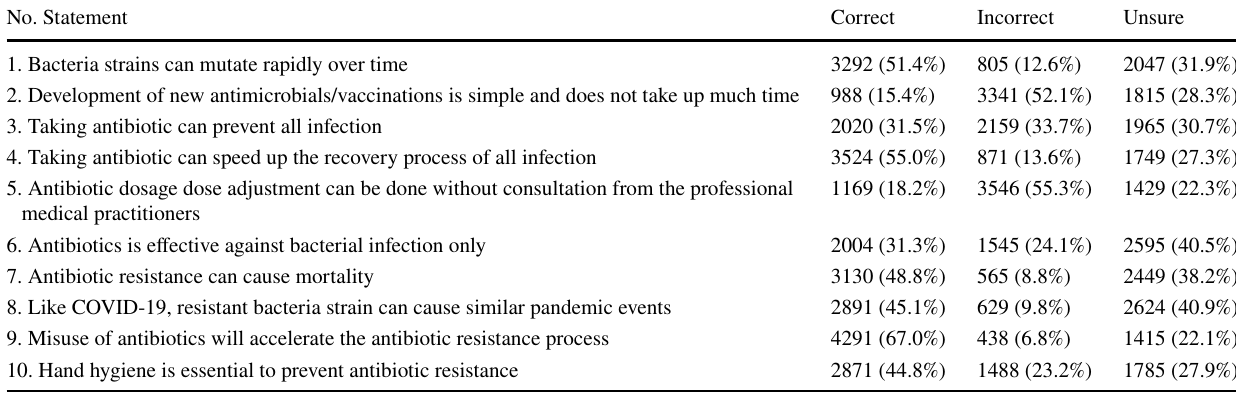
Table 6 Descriptive data of knowledge on antibiotics use and resistance No.